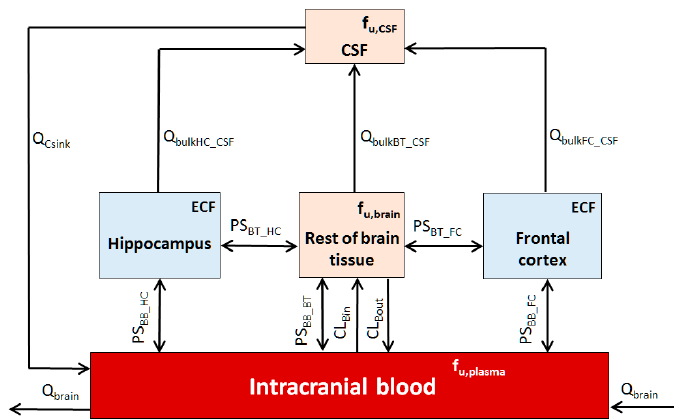
Figure 2. Five-compartmental rat CNS PBPK brain model. Q: blood flow; PS: permeability surface- area; BB: intracranial blood; HC: hippocampus; FC: frontal cortex; C and CSF: cerebrospinal fluid; BT: brain tissue; f u : drug fraction unbound in brain regions ( fu ,brain ), CSF ( fu ,CSF ) or plasma ( fu ,plasma